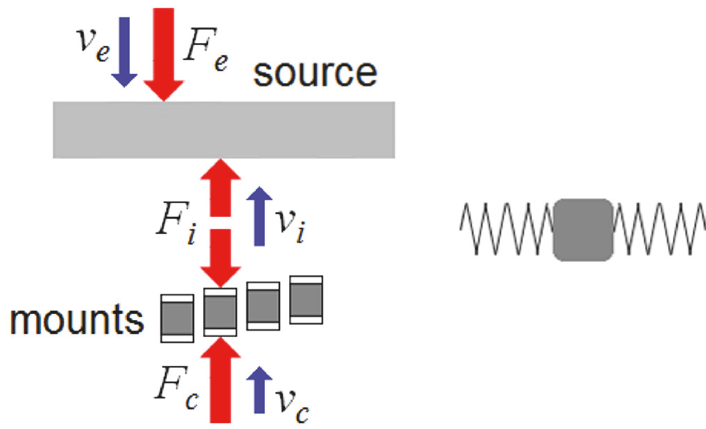
Figure 12: Left: assembled source. Right: mount